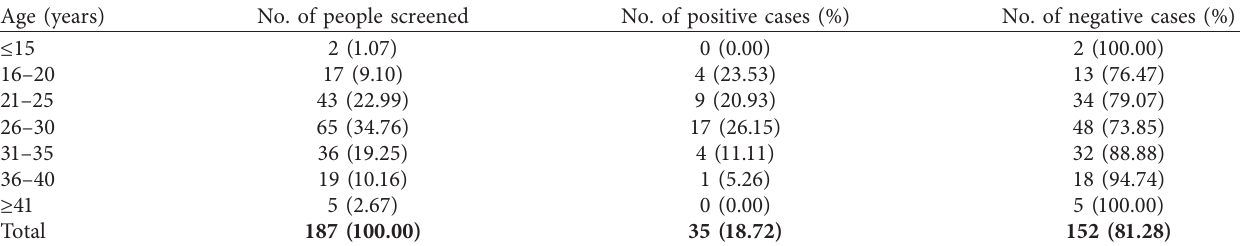
Table 1: Age spread of rubella IgM antibody among pregnant women.